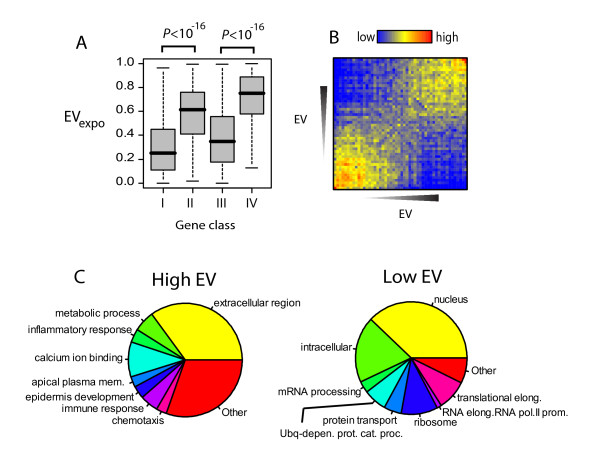
Functional significance of Expression Variance of human genes. A) Boxplots of EVexpo values of genes in the classes of genes as defined in Kim et al (2005) [8]. Class I of genes have RNA Polymerase PIC occupancy and active transcription, Class II has PIC occupancy but no active transcription, Class III have no or low (transient) PIC occupancy but active transcription, Class IV have no detectable PIC occupancy or transcription (see Kim et al (2005)). P-values of difference were calculated using Wilcoxon rank sum test. B) Heatmaps of interaction densities between low and high EVexpo genes based on functional relations. Each square i,j represents density of interactions between bins i and j as defined by number of interactions between bins i and j divided by total number of interactions of bins i and j in the network. C) Pie charts of most significantly enriched GO categories in 500 highest and lowest EVexpo genes. Significance of enrichment was assessed by hypergeometric distribution (P < 10-5). Only GO categories with more than 5 annotated genes were selected.